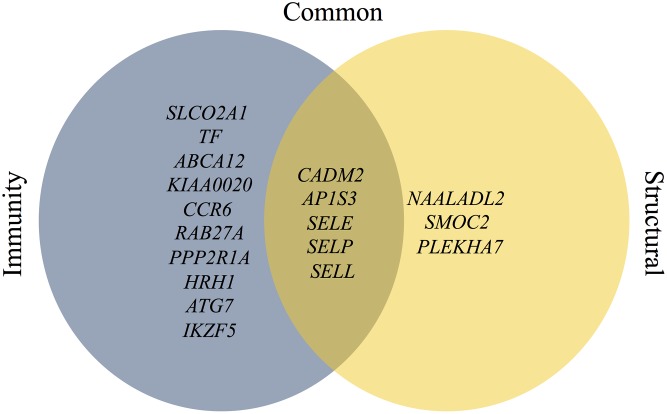
Genes and systems.Structural, genes involved in repair/wound healing processes without apparent immune function, including: adhesive activity, extracellular matrix (ECM) remodeling, epithelial-to-mesenchyme transition (EMT) and profibrotic activities; Immunity, genes involved in immunological activity; Common, genes involved in both.